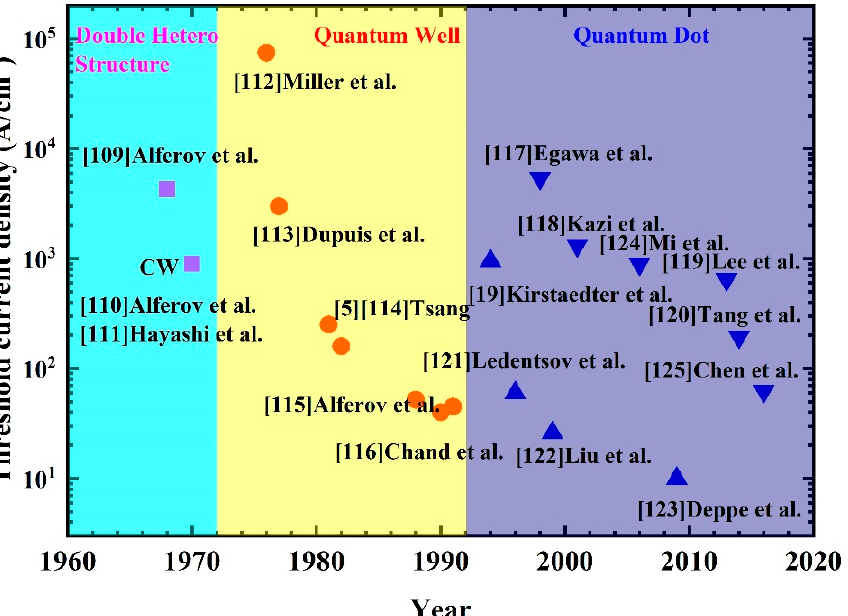
Figure 14. Historical development of heterostructure lasers showing the record threshold current densities at the time of publication ( (cid:78) QD laser on GaAs; (cid:72) QD laser on densities at the time of publication ( ▲ QD laser on GaAs; ▼ QD laser on Si).